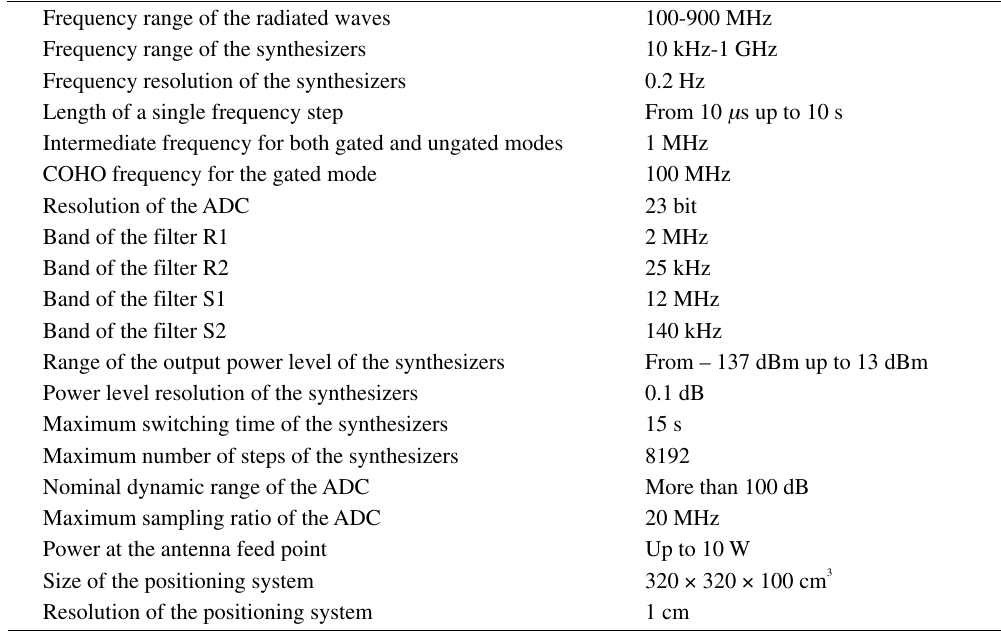
Table I. Some of the main characteristics of the